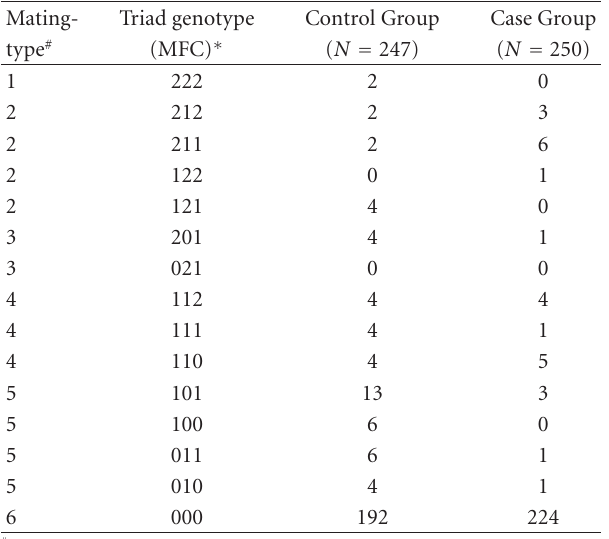
Table 3: LRTs for maternal and fetal genotype e ff ects and their